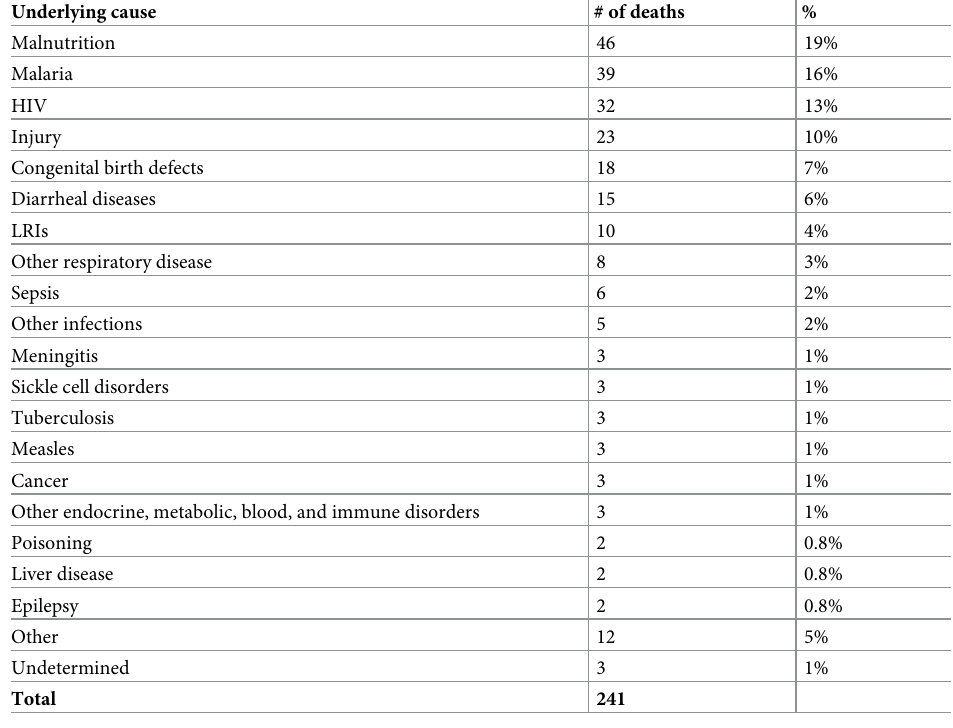
Table 3. Underlying causes for 241 child deaths.